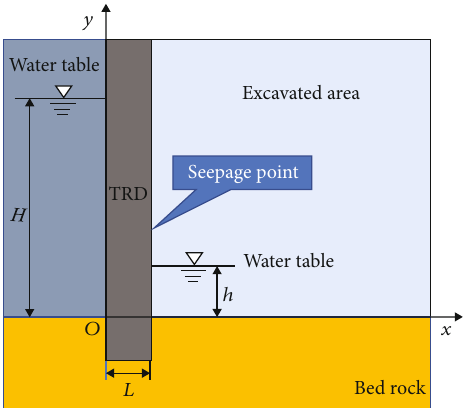
Figure 5: Pro fi le of the sand layer failure in TRD construction.